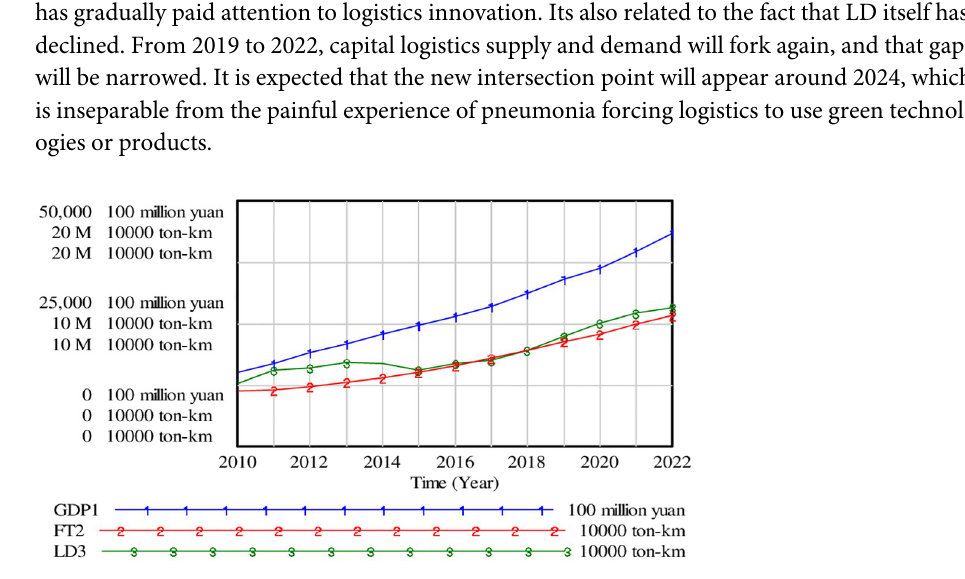
Fig 6. Simulation trend chart of economy and logistics